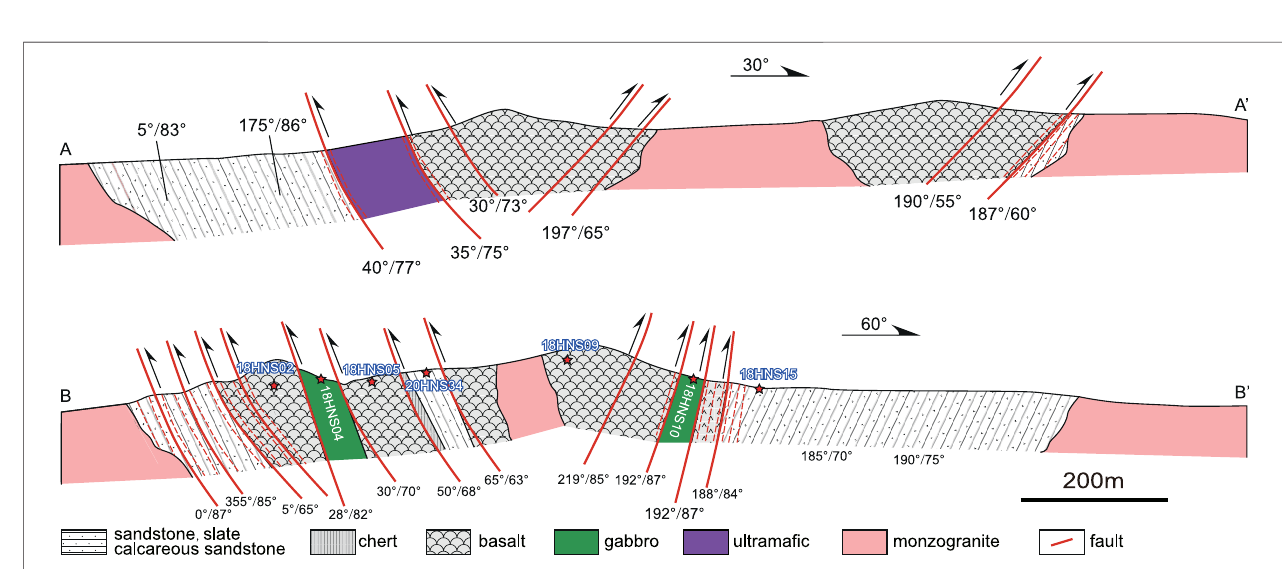
FIGURE 3 | Cross-sections of the Huaniushan complex; (A) cross-section ( A-A 9 ) in the western part; (C) cross-section (B-B 9 ) in the eastern part.